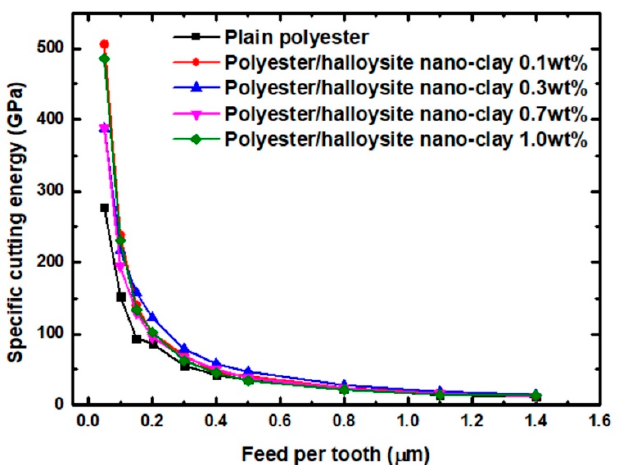
Figure 9. Experimental specific cutting energy for polyester/halloysite nano clay with the second set of machining parameters.